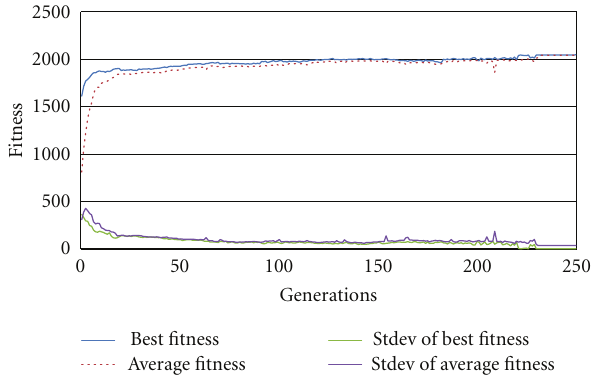
Figure 10: GA best and average